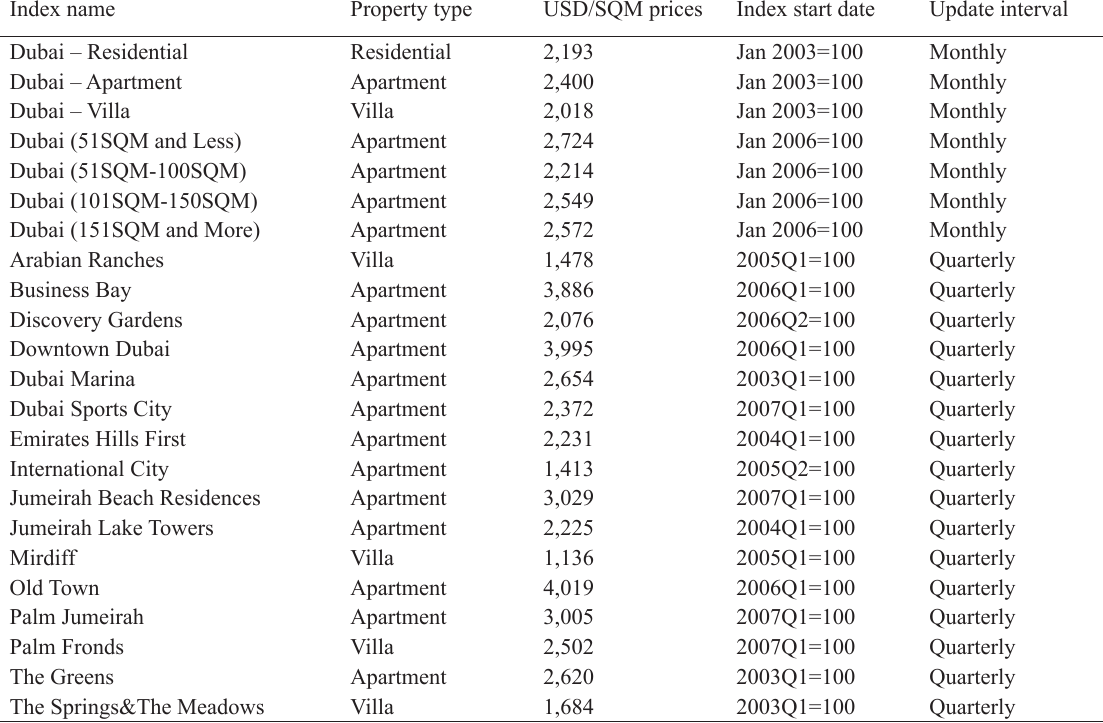
table 1. The reIDIn.com Dubai residential Property Price Index series and